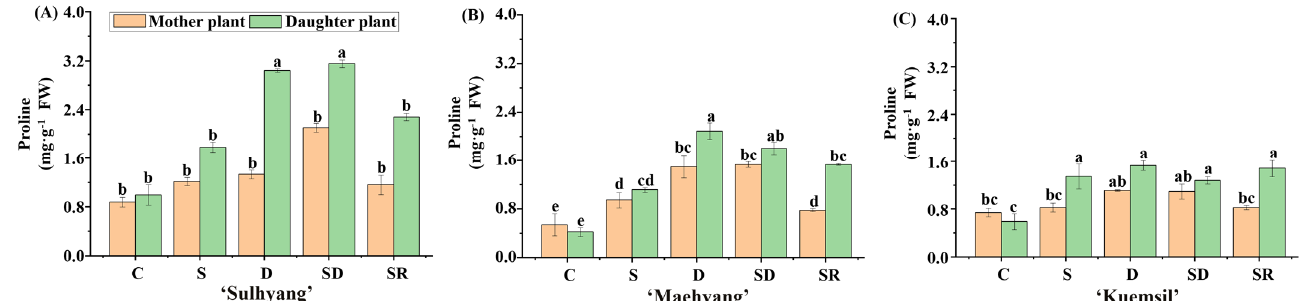
Figure 6. The proline content of strawberry ‘Sulhyang’ ( A ), ‘Maehyang’ ( B ), and ‘Kuemsil’ ( C ) as affected by the Si treatments. Lowercase letters indicate significant differences calculated by the Duncan’s multiple range test at p ≤ 0.05: C, control; S, sprayed “mother” plant; D, drenched “mother” plant; SD, dressed “mother” plant; and SR, sprayed “daughter” plant.